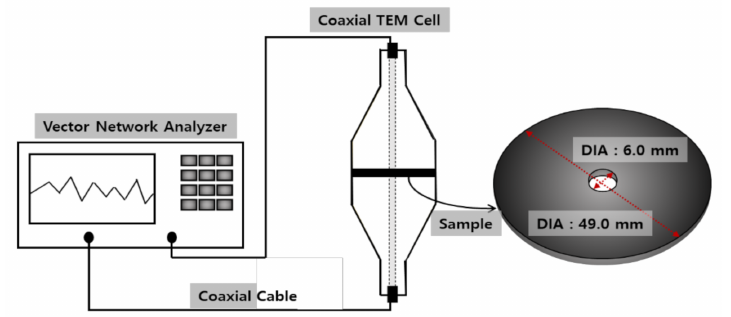
Figure 2. Schematic diagram of the test set-up and